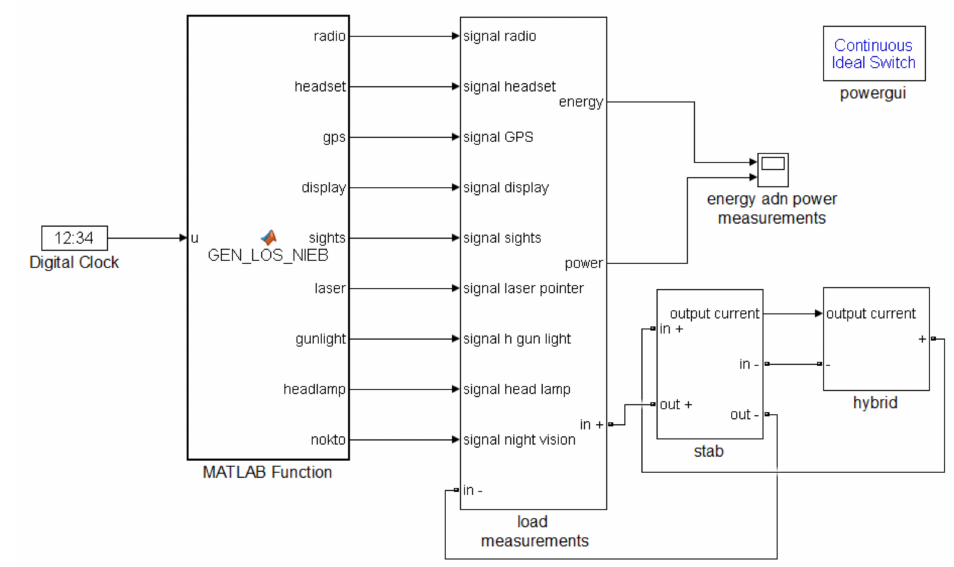
Figure 4. Base layer of the hybrid.